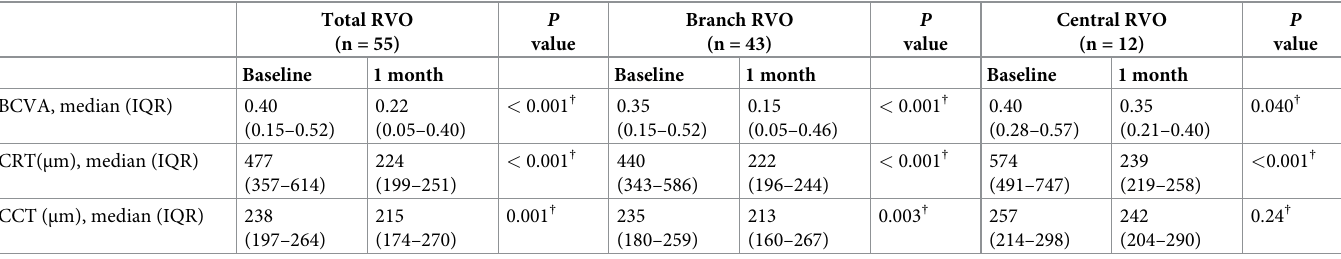
Table 3. Alterations of clinical data in patients with RVO by treatment.